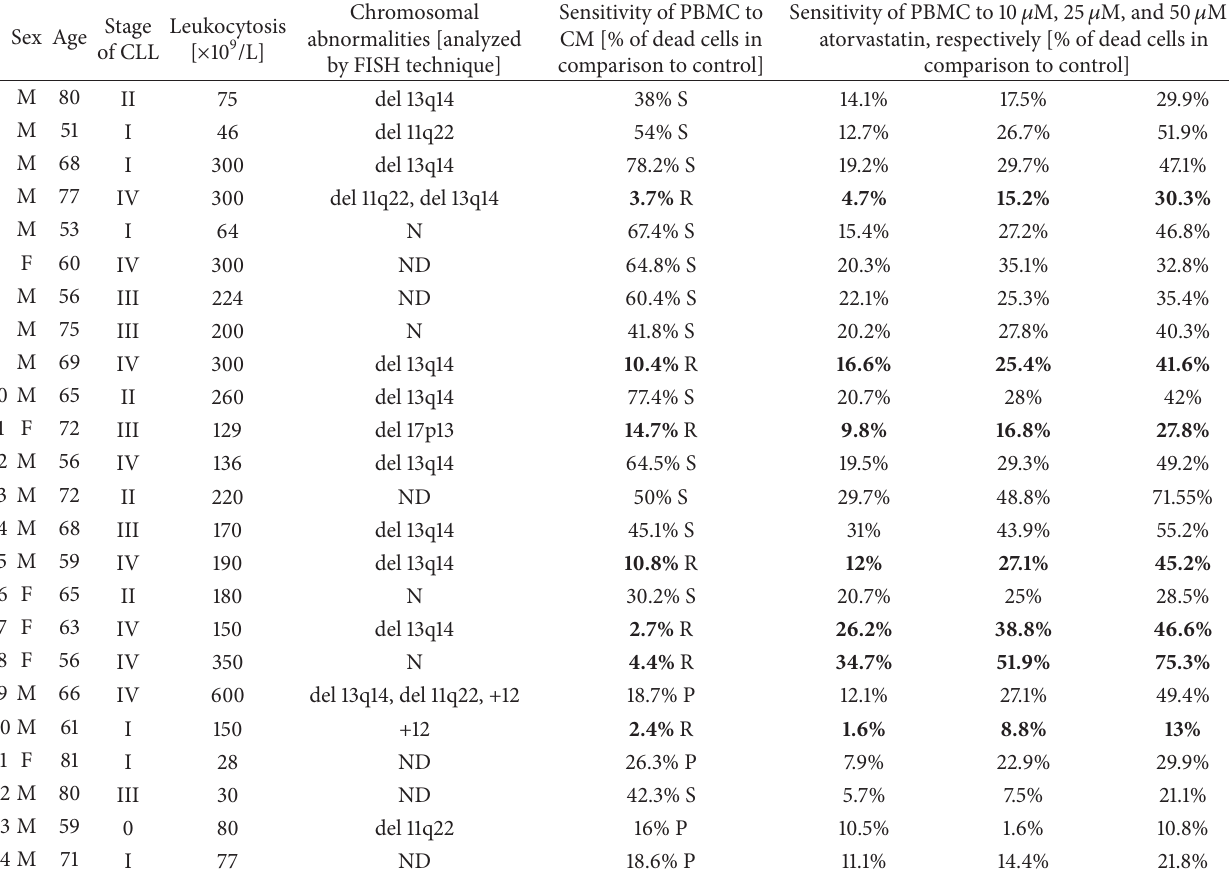
Table 1: Characteristic of CLL